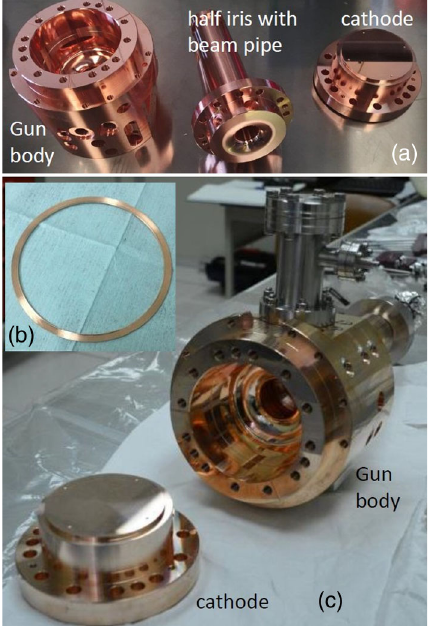
FIG. 14. (a) Main gun components before clamping; (b) special gasket; (c) gun during assembly.